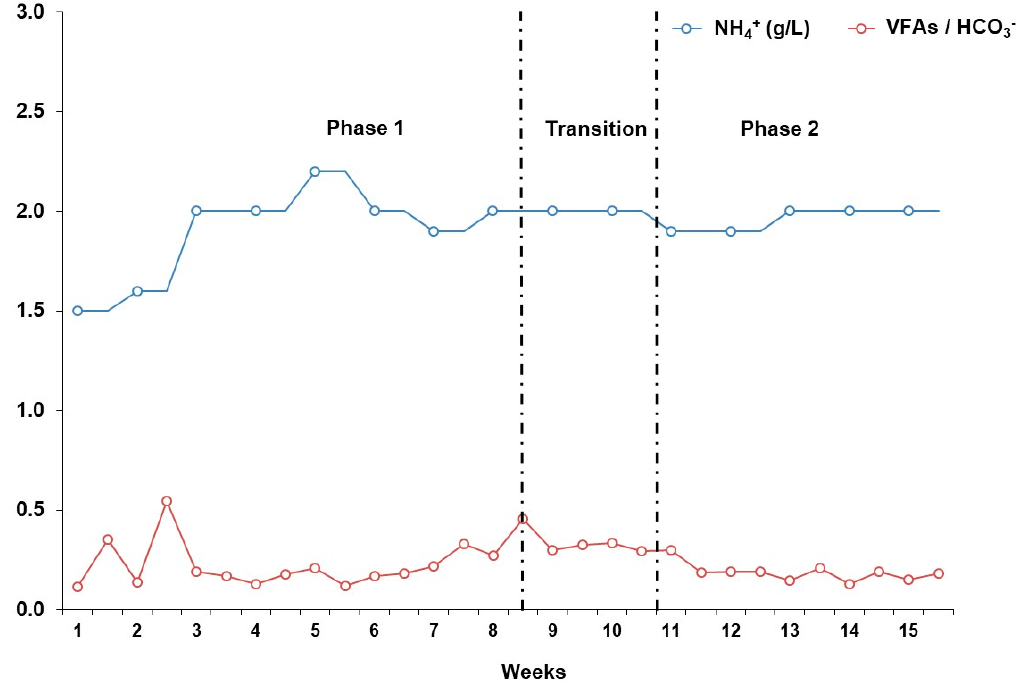
Figure 5. Methane production and methane yield at pilot-scale with the three different phases (phase 1, transition, phase 2).